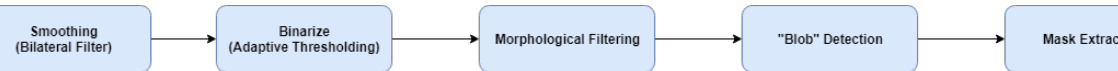
Figure 5. An example image with annotated segments of C. elegans.